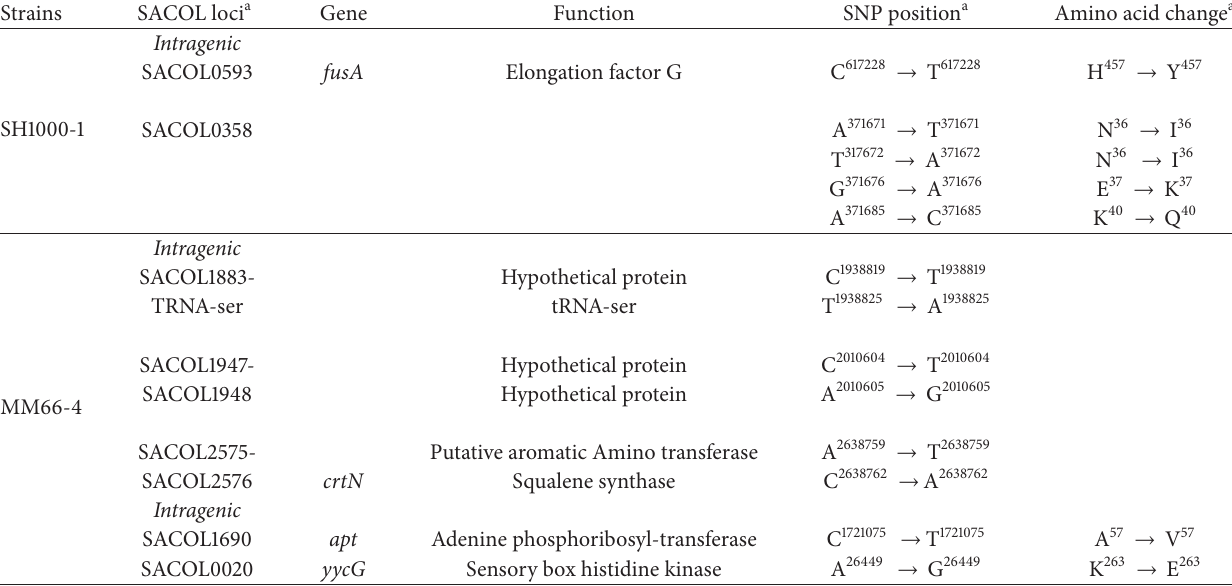
Table 2: Mutations detected in MM66 and SH1000-1 by comparative genome